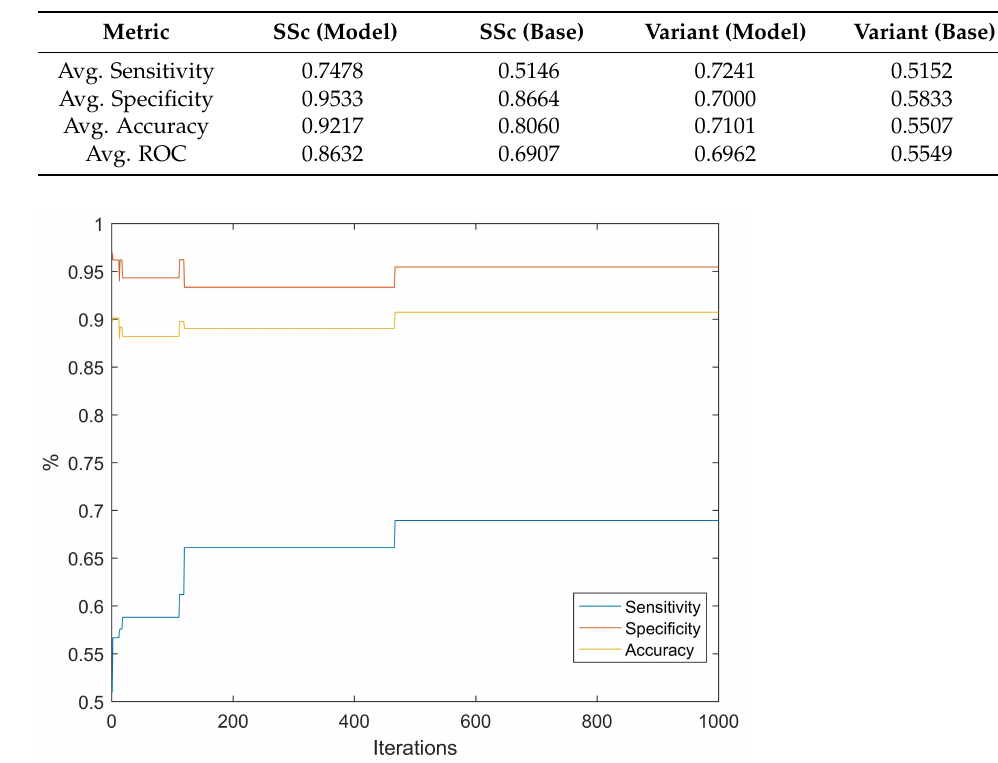
Figure 4. Sensitivity, specificity and accuracy of a sample